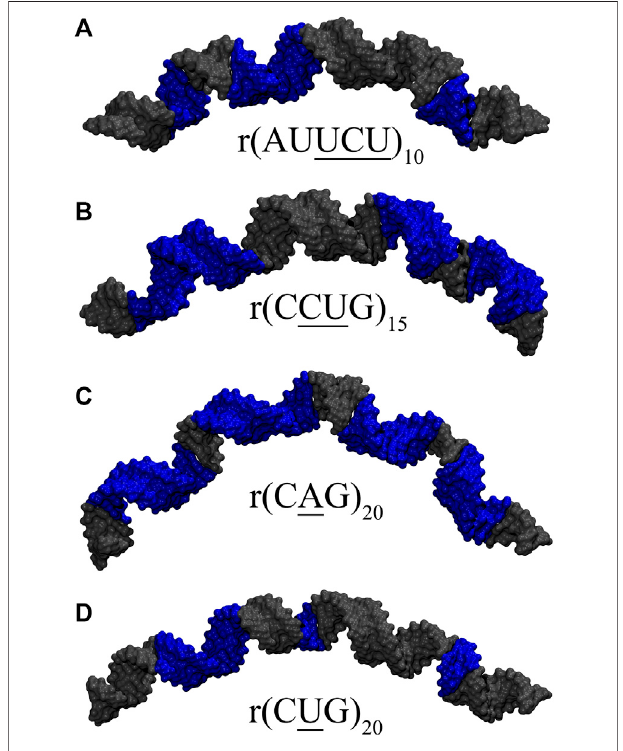
FIGURE 7 | Loop conformations observed in representative clusters having extreme bending in (A) 10×AUUCU, (B) 15×CCUG, (C) 20×CAG, and (D) 20×CUG. Structures highlighted in Supplementary Table S4 are displayed in the fi gure. Blue colored regions in (A,B) are RNA loop conformations having distorted closing GC or AU base pairs ( Figures 4C – E , 5D,F ), while in (C,D) , they represent weakest RNA loop conformations ( Figures 6A,D,E ). See Supplementary Figure S12 for